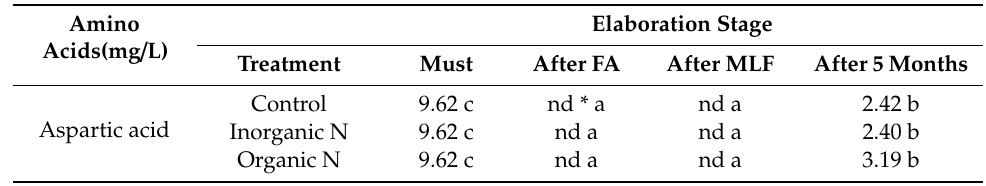
Table 3. Average values of the amino acids content during the production and preservation of wines made from musts with di ff erent nitrogen